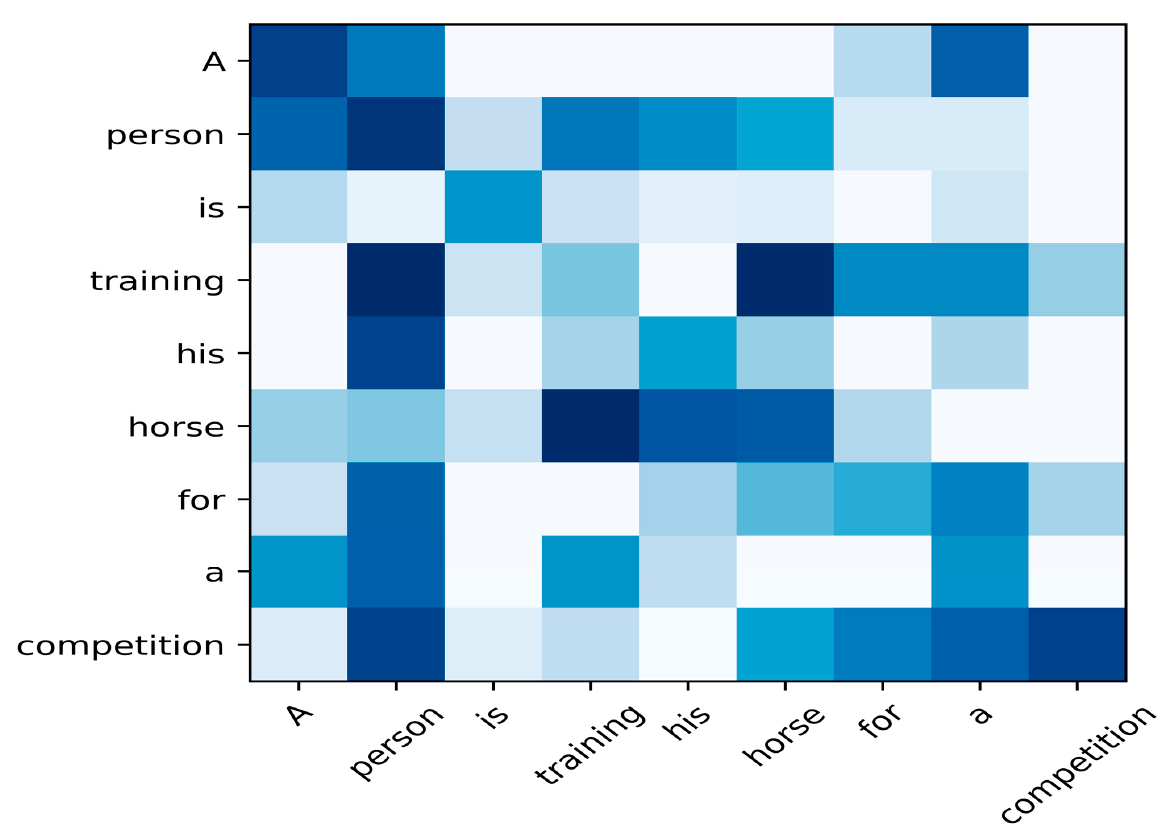
Figure 6. Visualization results of multi-layer semantic representation network.